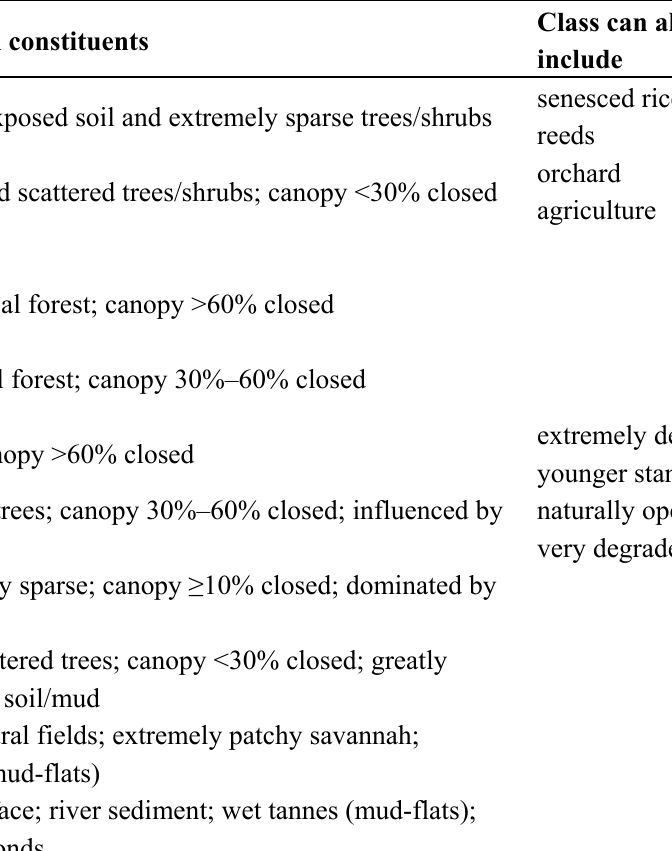
Table 1. Mapped classes and